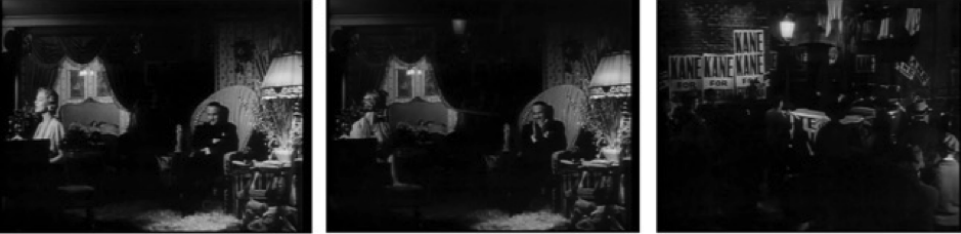
Figure 9: The use of Overlapping in “Citizen